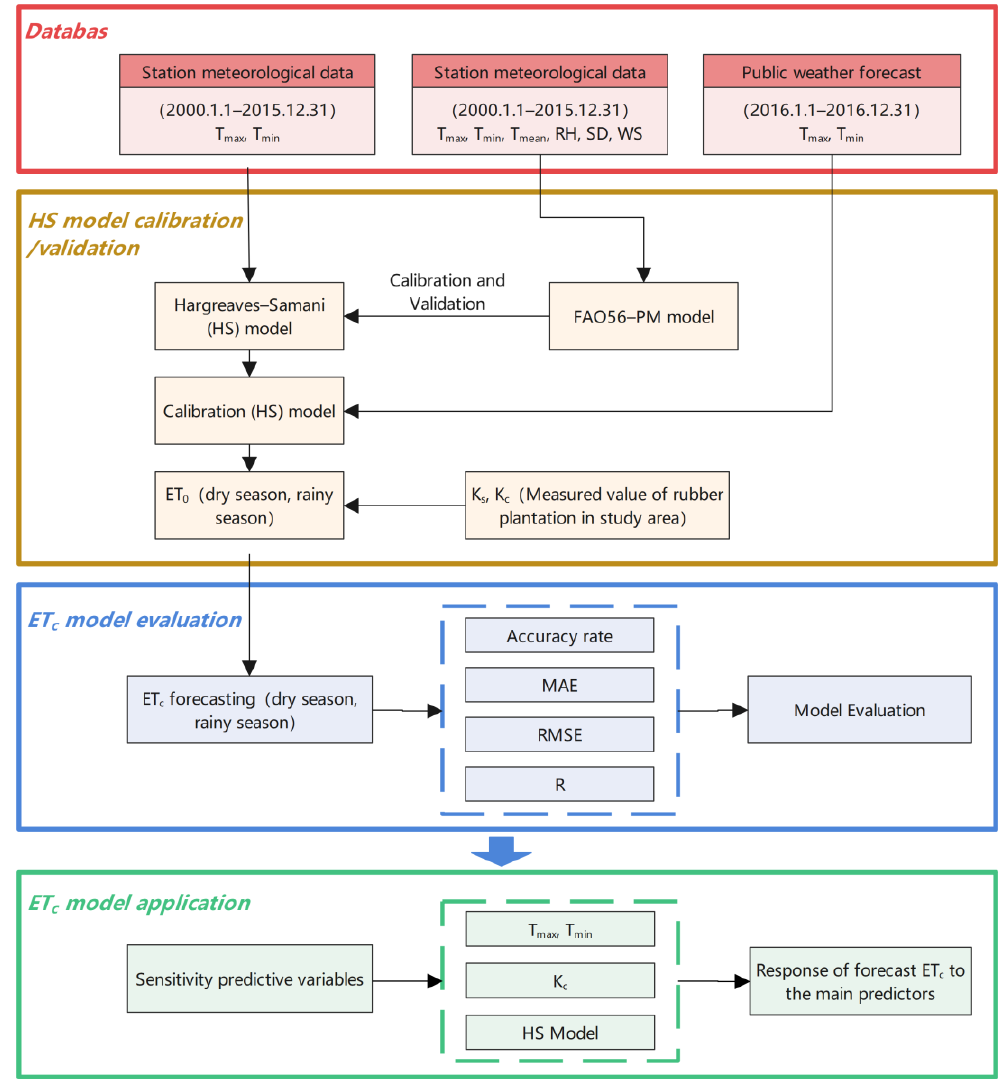
Figure 3. Framework of the rubber plantation ET c forecast integrating public weather forecast data with the “ K c -ET 0 ” method using the HS model. (RH, relative humidity; SD, sunshine duration; WS,wind speed; ET 0 , reference evapotranspiration; ET c , crop evapotranspiration; K c , the crop coef- ficient; K s , soil water stress coefficient; MAE, the average absolute error; R, the average correlation coefficient; RMSE, the root mean square error).